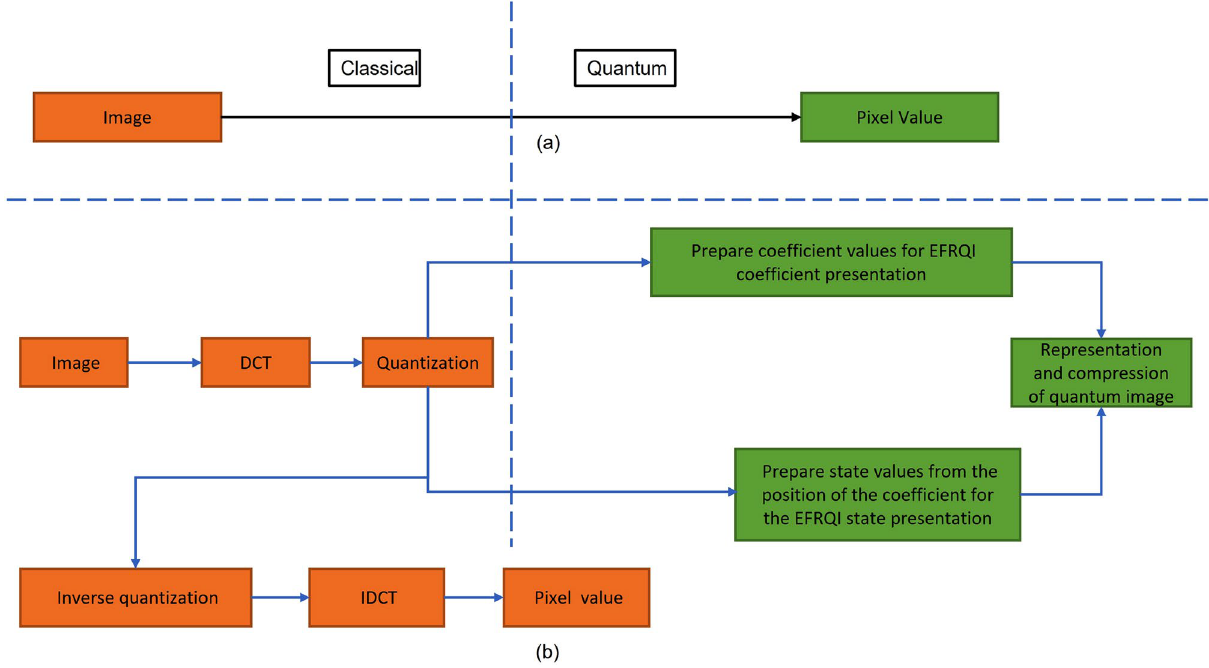
Figure 4. ( a ) Traditional scheme and ( b ) Proposed scheme.